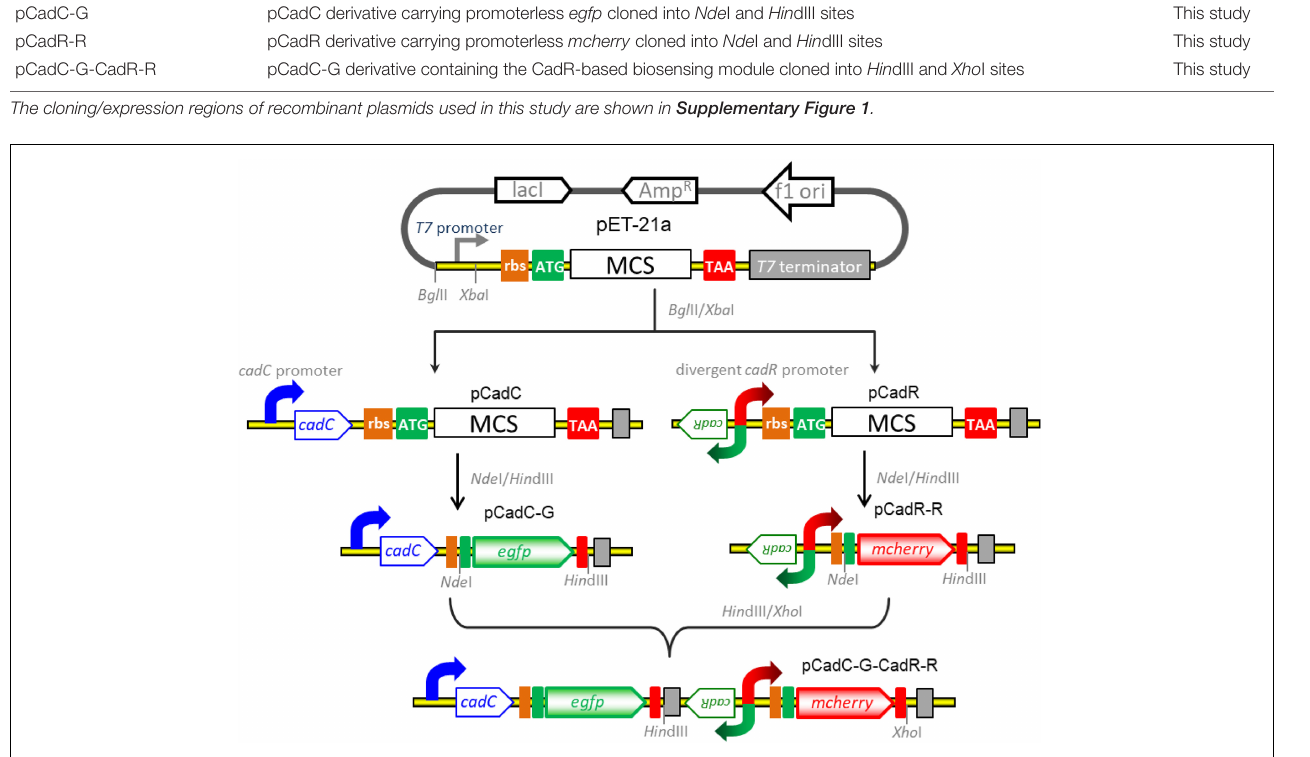
FIGURE 1 | Genetic assembly and merger of two independent biosensing modules into one genetic construct for the detection of bioavailable cadmium. The green fluorescent reporter was placed downstream of the cadC promoter and cadC gene (pCadC-G). The red fluorescent reporter was placed under the regulation of the native cadR promoter (pCadR-R). Two independent sensing modules were integrated into one genetic construct (pCadC-G-CadR-R).